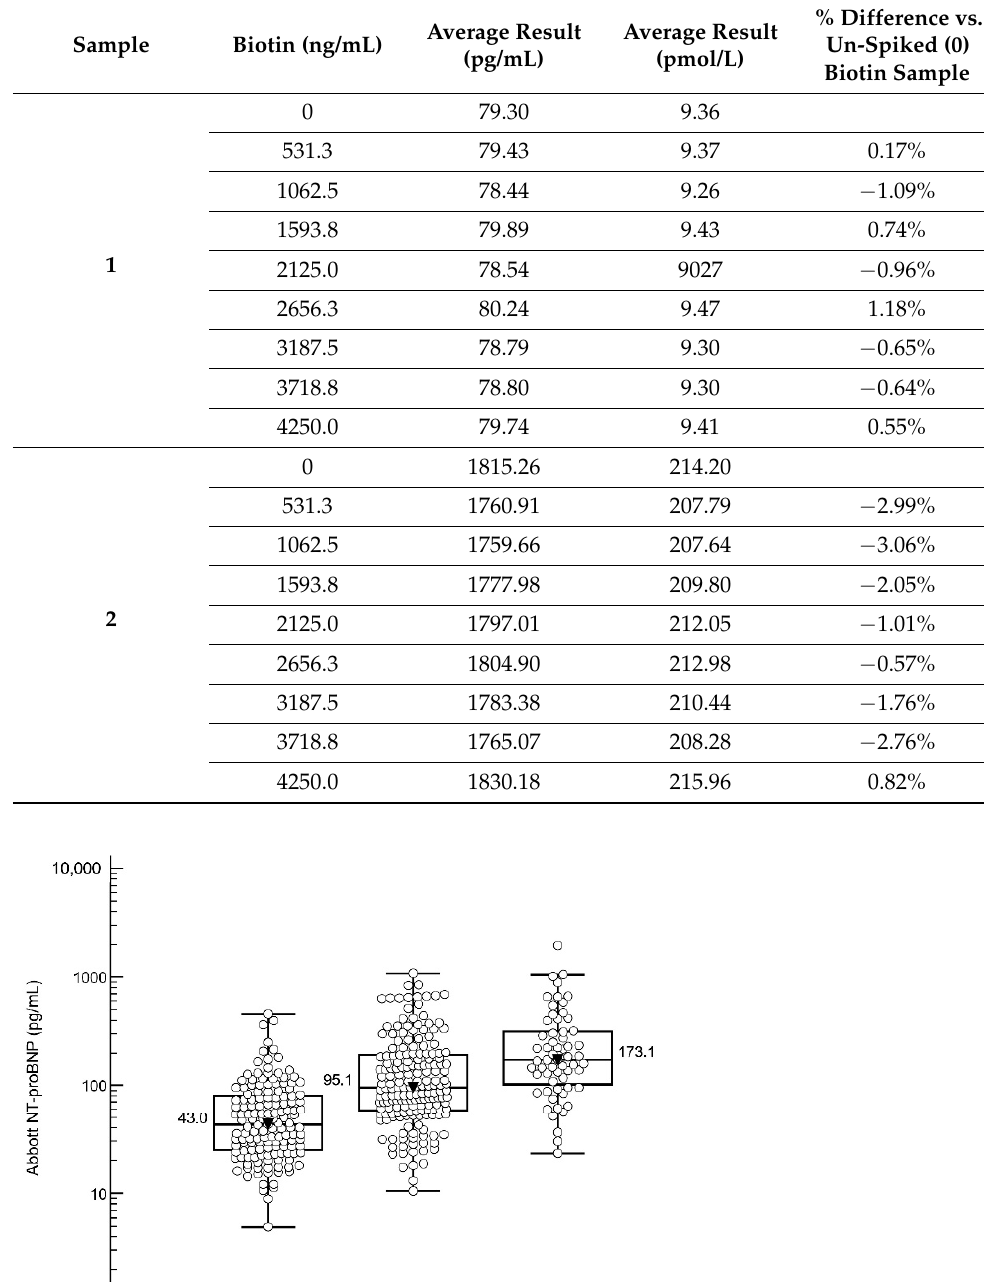
Table 2. Biotin recovery on the Abbott Alere NT-proBNP assay for the Architect analyser with increasing levels of biotin.